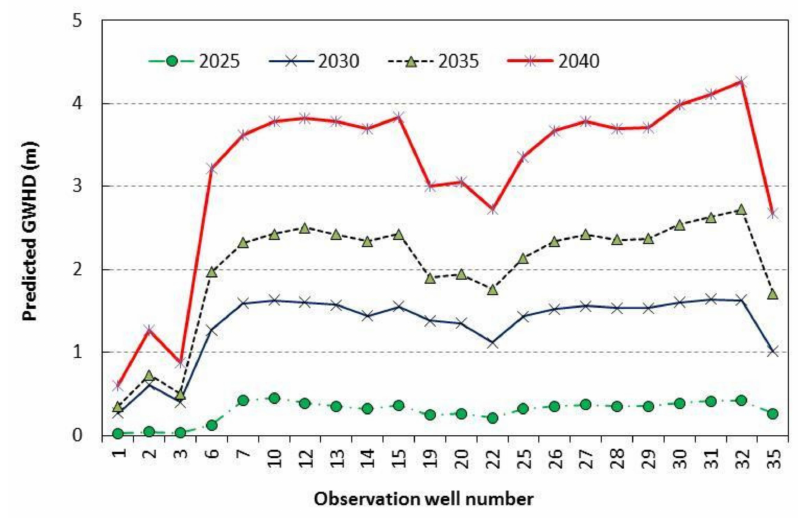
Figure 11. The relation between GWHD and observation well number for the leakage of drinking water and sewage networks.